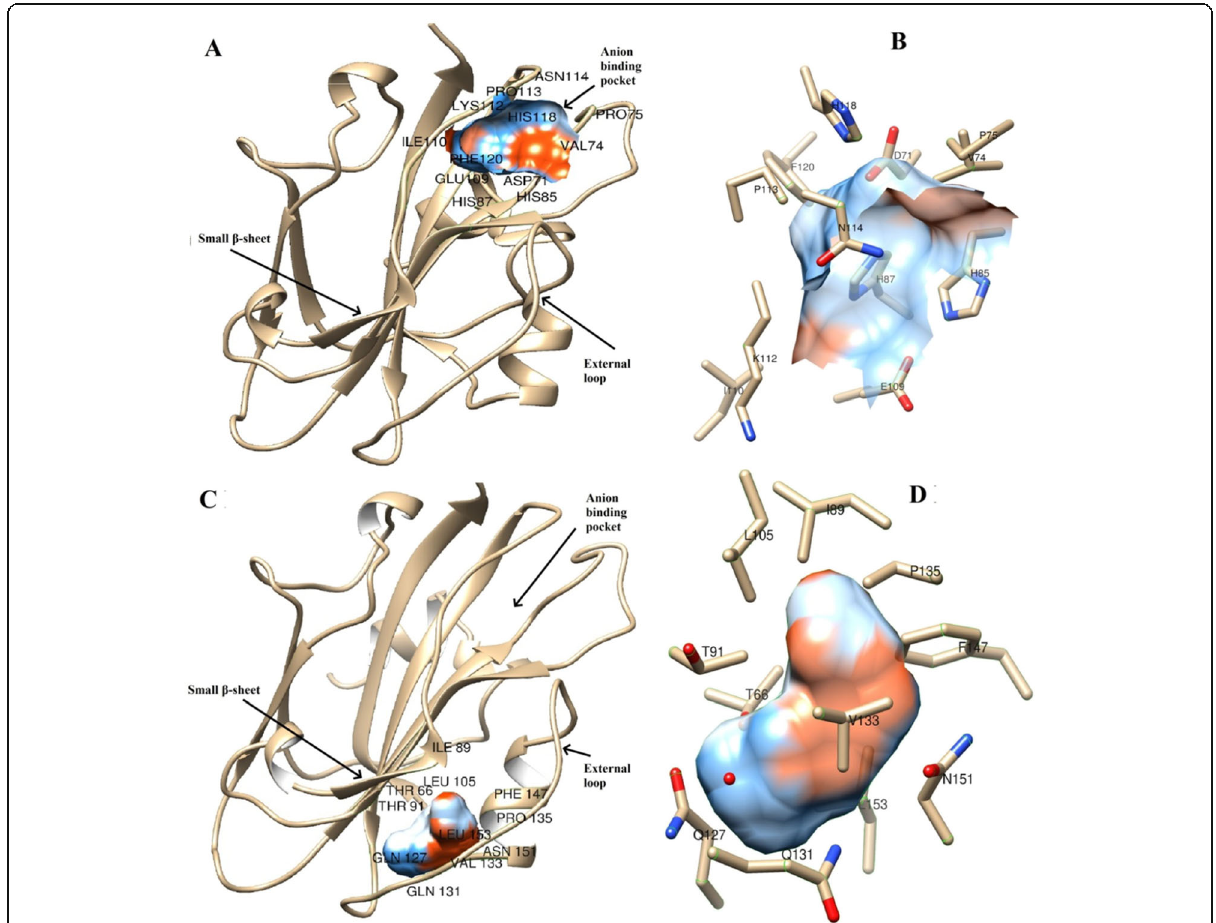
Fig. 5 Predicted binding pockets of modelled TFL protein of GPKH 120 based on geometrical and topographical properties. a Predicted anion- binding pocket and the amino acid residues involved in its formation. b Close-up view of amino acid side chains involved in formation of anion- binding pocket. c Predicted a secondary binding pocket involving small β -sheet and external loop along with amino acid residues involved in its formation. d Close-up view of amino acid side chains involved in formation of a secondary binding